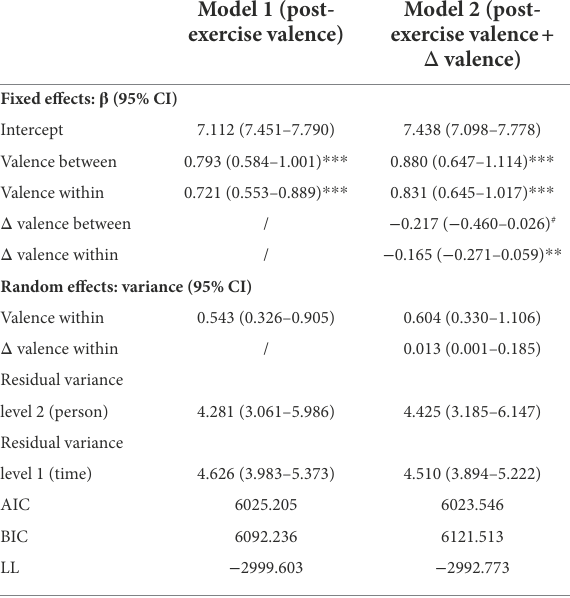
TABLE 2 Results of hierarchical linear models for the prediction of weekly intention by affect. Model 1 (post- Model 2 (post- exercise valence) exercise valence